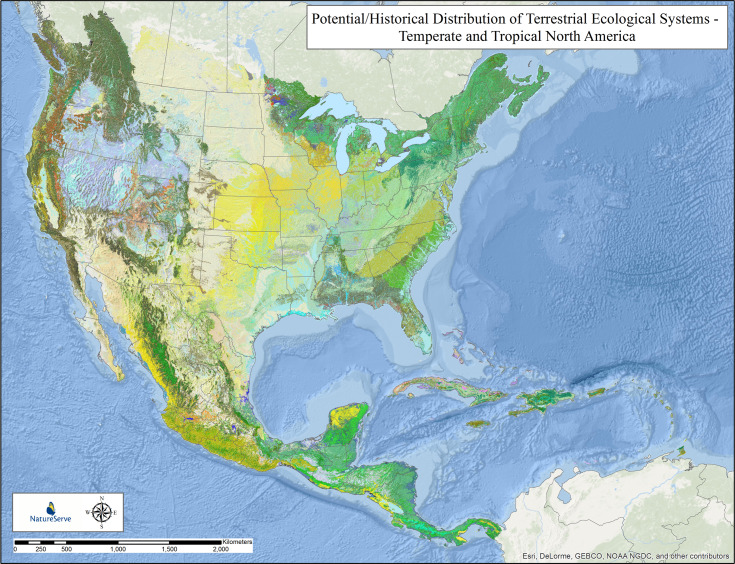
Potential/historical distribution of terrestrial ecological systems—temperate and tropical North America.Potential distribution of 623 terrestrial ecological system units in Temperate and Tropical North America. Individual types are too numerous to list in a legend, but this provides a depiction of patterns that will be discernable in part in subsequent figures.